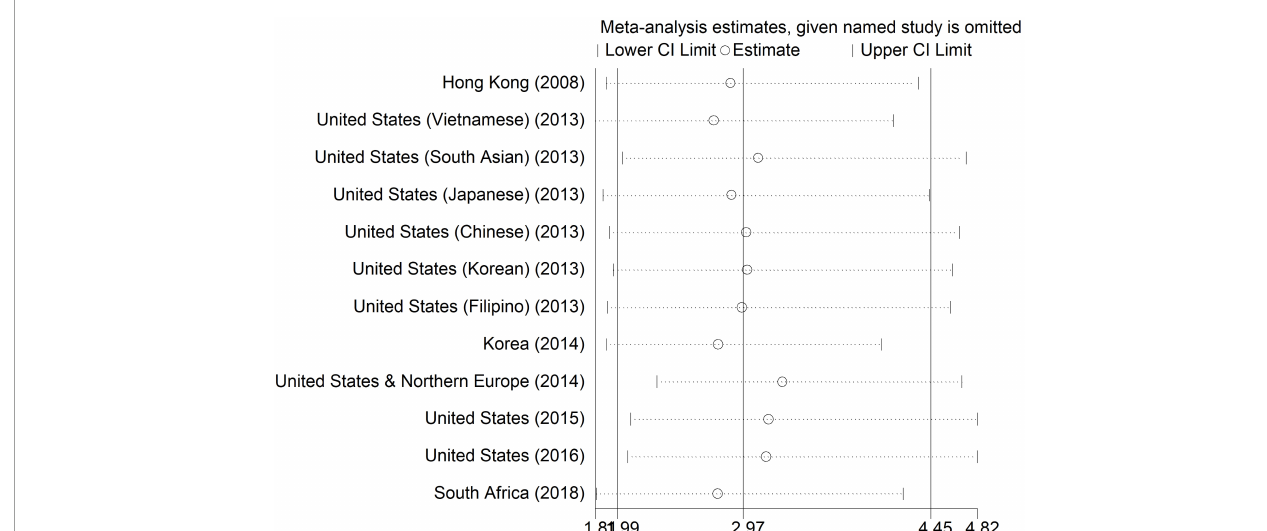
FIGURE5 Metaninf plot of the association between current smoking and binge drinking in both sexes.